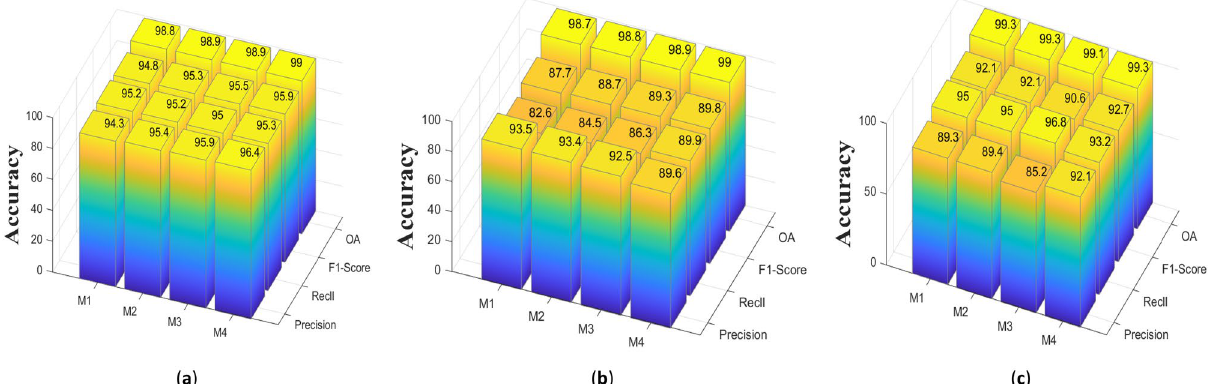
R2019a” url: https:// ww2. mathw orks. cn/ produ cts/ matlab. html).